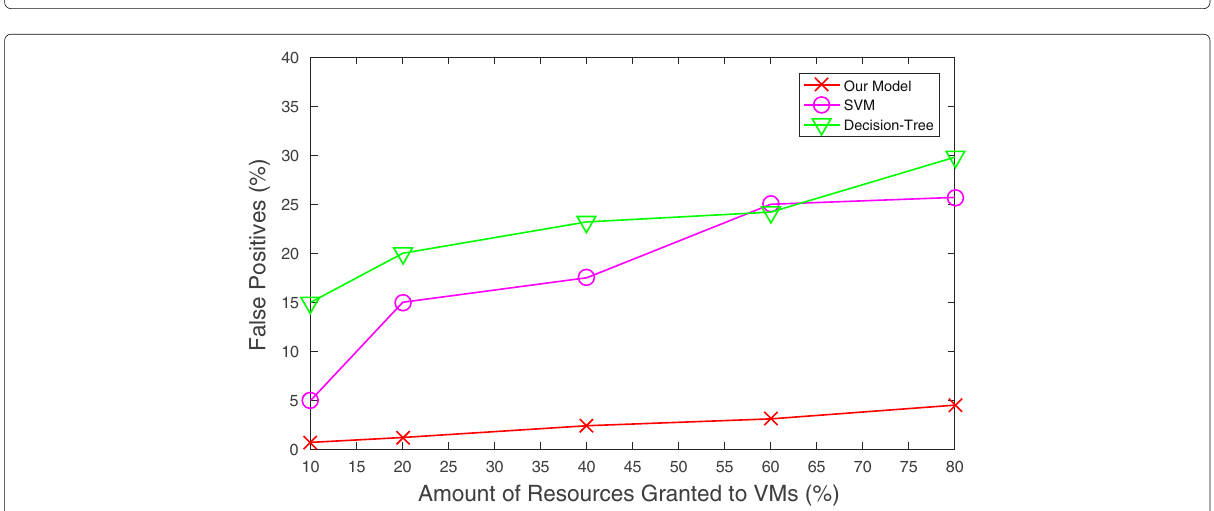
Fig. 10 False positive percentage w.r.t. amount of granted